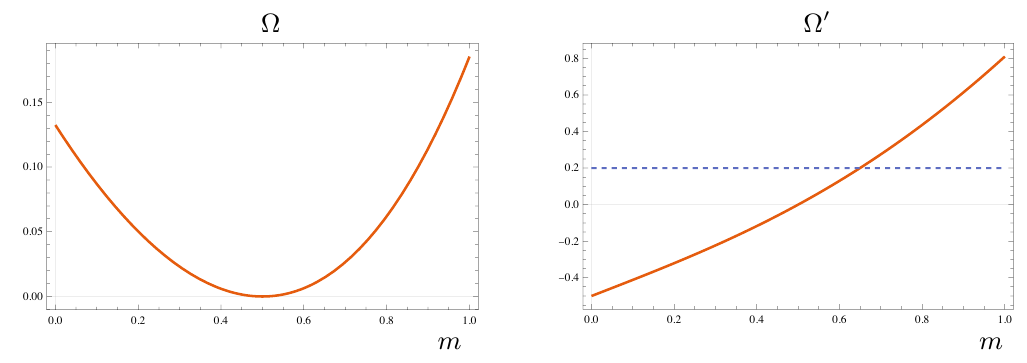
Figure 4 . The grand potential Ω( m ) (left) and its first derivative Ω 0 ( m ) (right) on the two- sphere. The function Ω( m ) is convex for all values of m and has a minimum for m = 1 / (2 r maximization condition has a solution with Q ≥ 0 in the region m ≥ 1 / (2 r